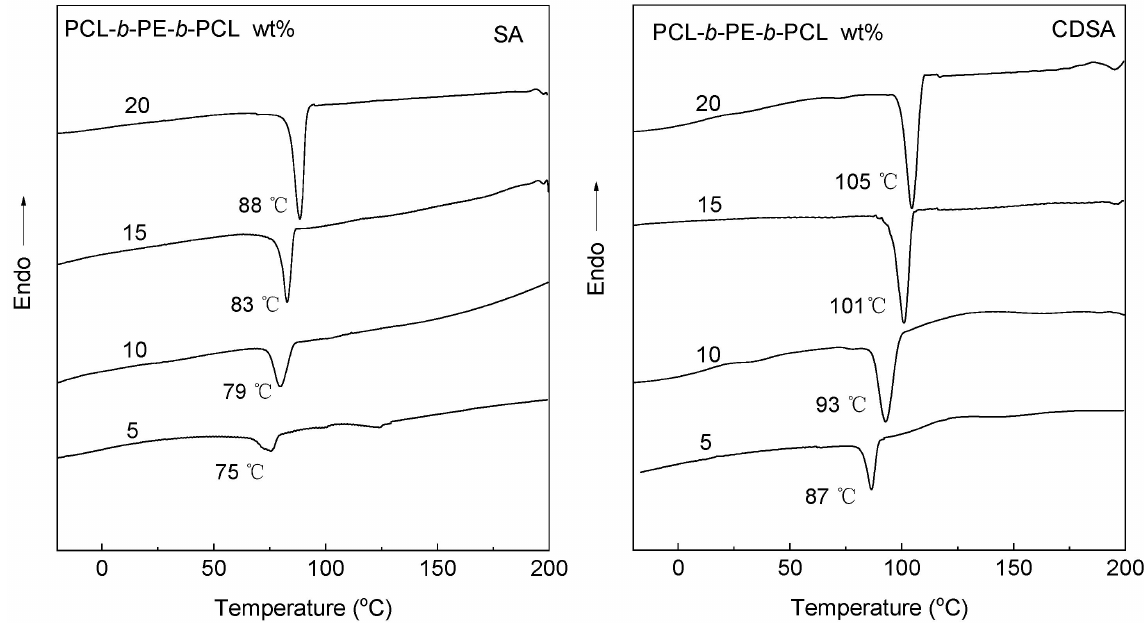
Figure 8. Cooling DSC curves of the nanostructured thermosets via SA and